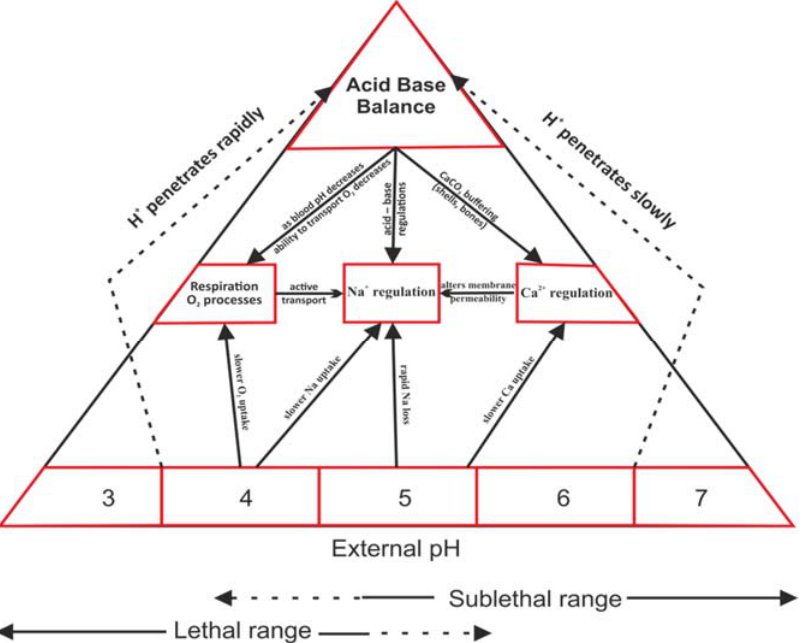
Figure 1. Diagram of the physiological response of aquatic organisms to decreased pH in the water environment.